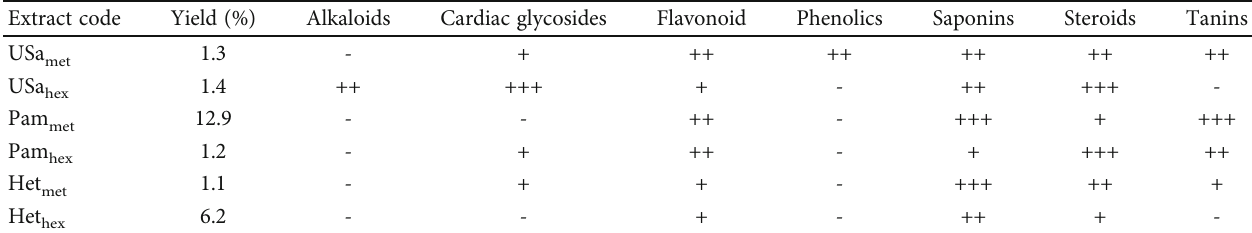
Table 1: Yield and classes of secondary metabolites in lichen extracts.